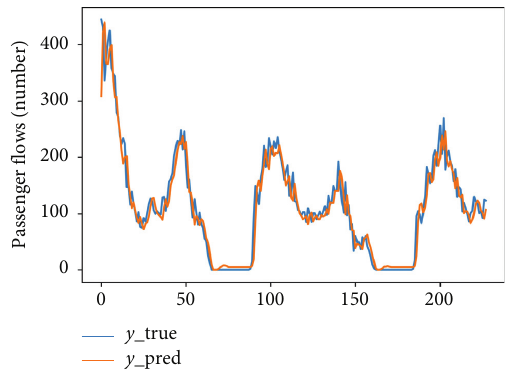
Figure 18: Regression integration prediction results when the time step is